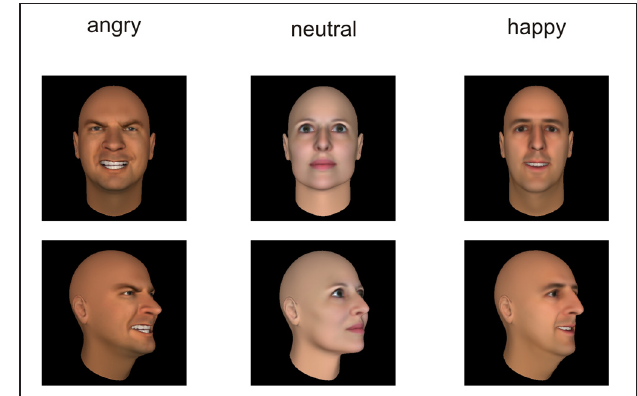
FIGURE 2 | Examples of the presented stimuli depicting faces from a frontal (top) and averted (bottom)